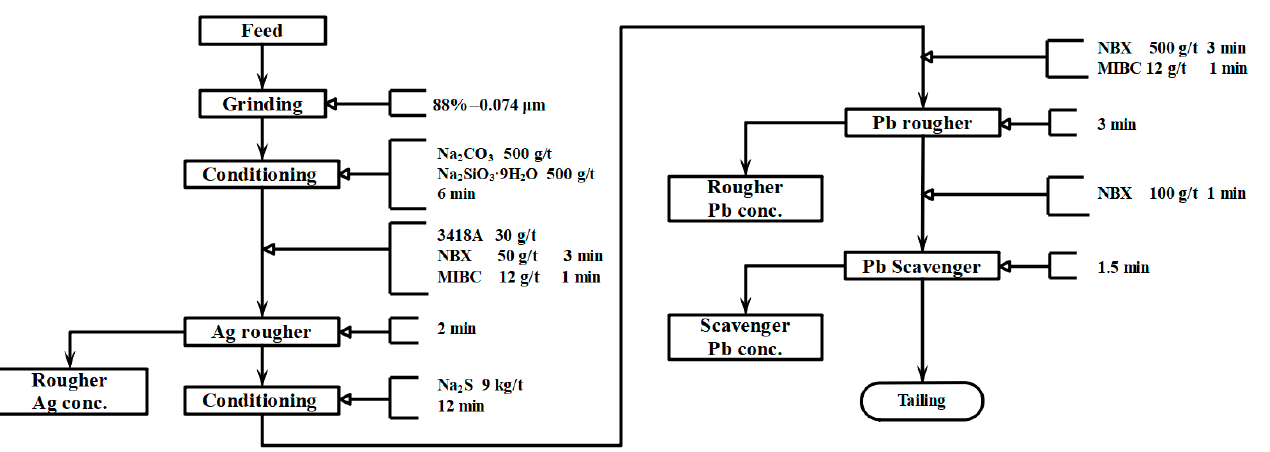
Figure 5. ( a ) Yield and recovery of products under different collector conditions; ( b ) content of products under different collector conditions.